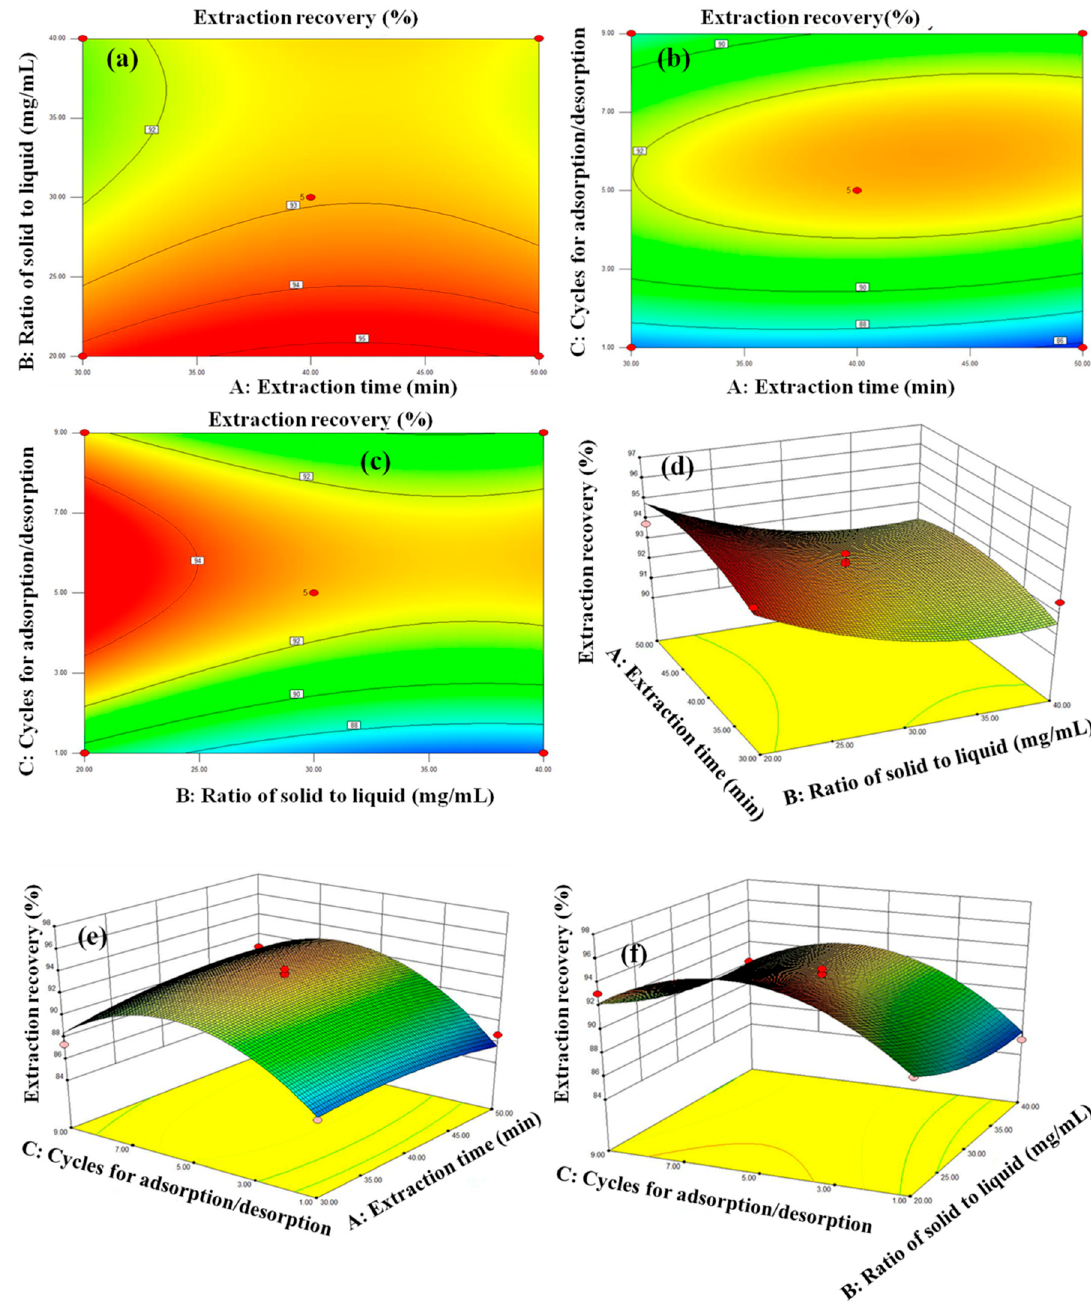
Figure 8. The contour plot ( a – c ), and reciprocal 3D response interaction ( d – f ) on the HMICS extraction recovery yield of three variables (e ff ects of extraction time, ratio of solid to liquid, cycles extraction recovery yield of three variables (effects of extraction time, ratio of solid to liquid, cycles for adsorption/desorption).